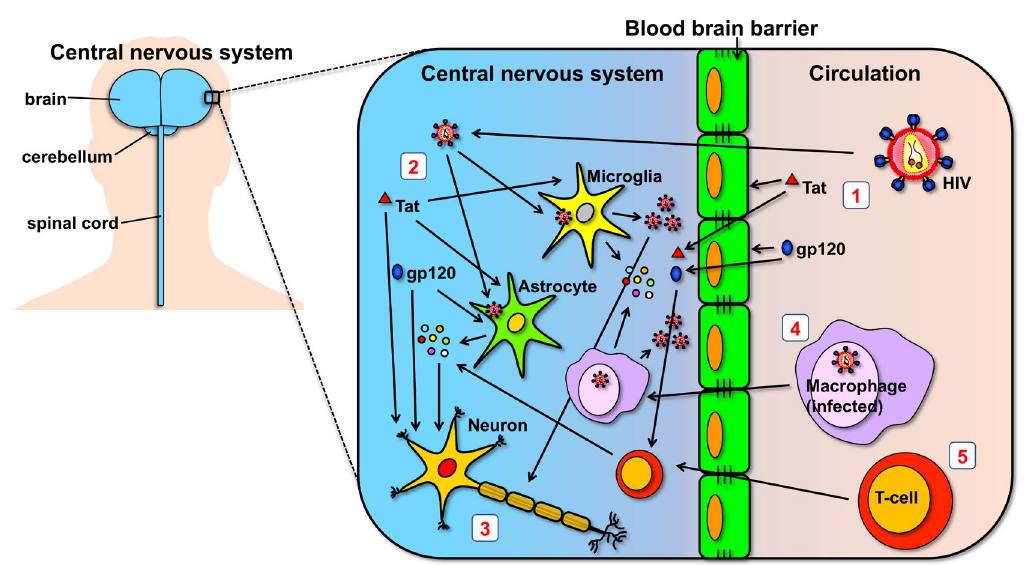
Figure 1 . Summary of mechanisms of neuropathogenesis in the CNS. (1) HIV and HIV proteins glycoprotein 120 (gp120) and trans-activator of transcription (Tat) found in circulation are able to cross the BBB and reach the CNS. Importantly, they can cause direct damage to the cells forming the BBB; (2) once in the CNS, HIV is able to infect and replicate in microglia and astrocytes, cells which may also be affected by the direct toxic effects of Tat and gp120; (3) HIV virions and the two viral proteins, gp120 and Tat, can generate neuronal damage directly by acting on neurons, and indirectly by the cytokines that are released by bystander cells; (4) HIV can also cross the BBB by travelling inside macrophages which were infected in the periphery, using what is called the “Trojan horse” strategy; (5) similar to macrophages, T-cells can also infiltrate the CNS and have a role in